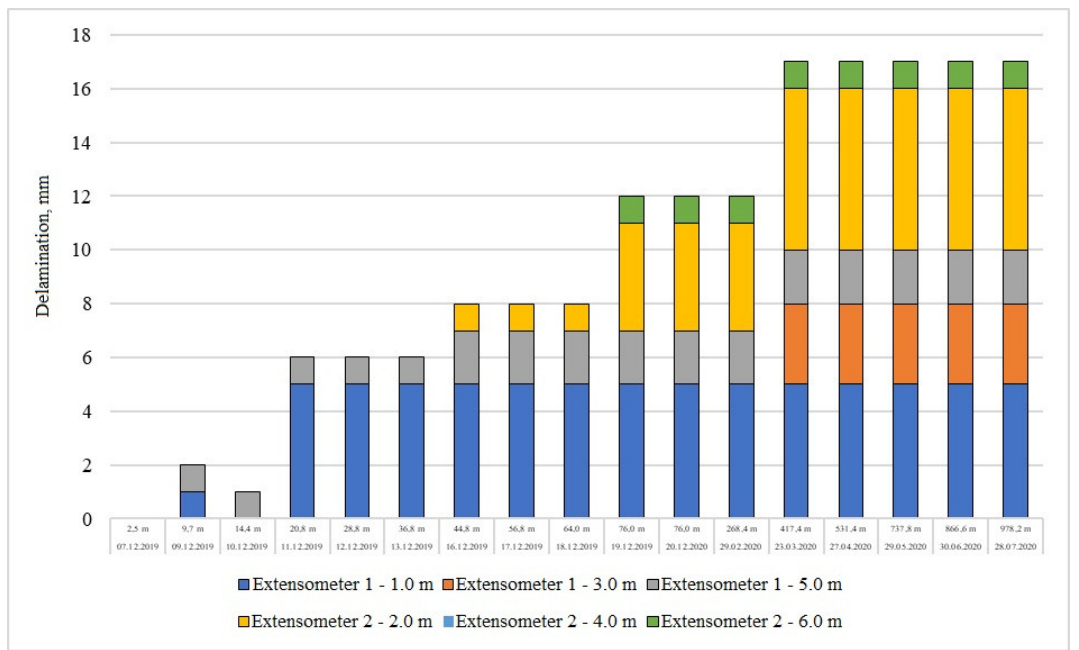
Figure A1. Roof delaminations measured using multilevel mechanical extensometer—periodic control station no. 2.